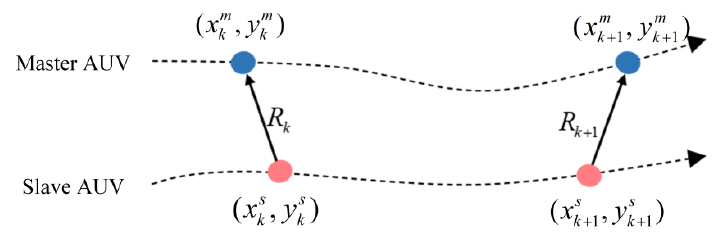
Figure 3. Schematic of the Multi-AUV cooperative navigation observability.